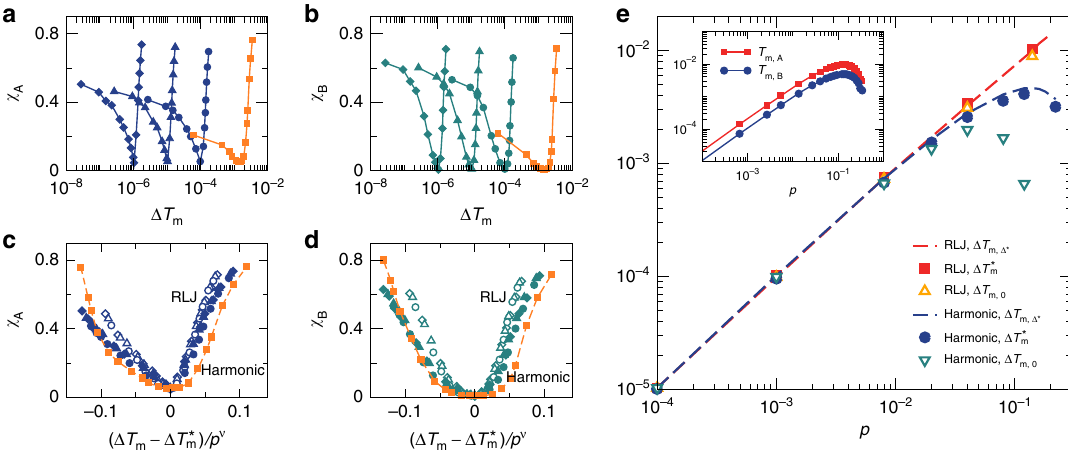
Fig. 4 Role of the melting temperature gap. Here we show results for γ = 1.4 and c B = 0.5 systems with the variation of Δ at ~ κ ¼ 1 : 22 ´ 10 (cid:2) 6 . a , b χ A ( Δ T m ) and χ B ( Δ T m ) of solid-like states for harmonic systems at p = 10 − 5 (diamonds), 10 − 4 (triangles), 10 − 3 (circles), and 0.02 (squares). The curves in orange are at p > p c where T m ( p ) is nonlinear, while other curves are at p < p c . c , d Scaling collapse of χ A ( Δ T m ) and χ B ( Δ T m ) for harmonic (solid) and RLJ (empty) systems at p = 10 − 5 (diamonds), 10 − 4 (triangles), 10 − 3 (circles), with ν ≈ 1.02. Δ T (cid:3) is the value of Δ T m at which χ A and χ B reach the minimum, as shown m in a , b . The squares with a dashed line show the violation of the scaling at p = 0.02 > p c for harmonic systems. e Comparison of melting temperature ð p Þ , Δ T ð p Þ with Δ = Δ * de fi ned in Eq. (14), and Δ T p ) with Δ = 0 for harmonic and RLJ systems. The inset shows T p ) and T p ) with gaps Δ T (cid:3) m,0 ( m,A ( m,B ( m ; Δ (cid:3) m Δ =